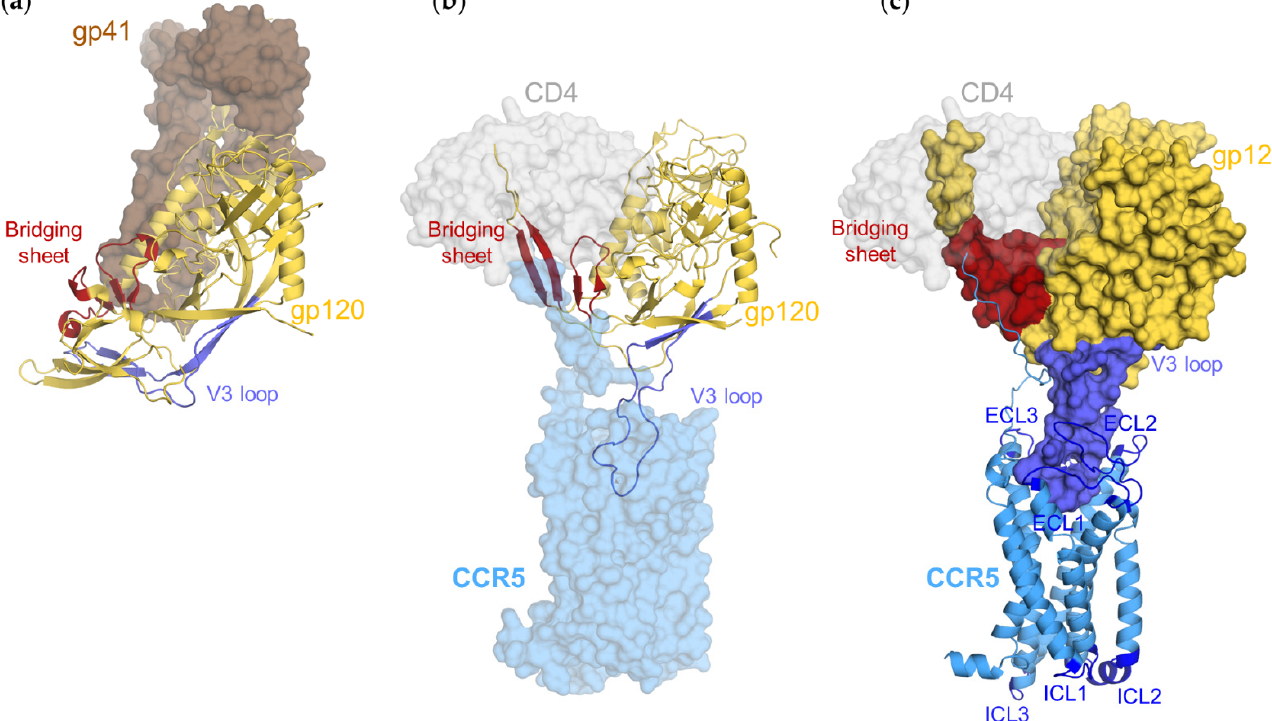
Figure 1. Structures of gp120 and its domains: ( a ) structure of closed form of gp120 (gold cartoon) in complex with gp41 (dark brown surface); ( b ) structure of open form of gp120 (gold cartoon) in complex with CD4 (gray transparent surface) and CCR5 (blue transparent surface); ( c ) structure of open form of gp120 (gold surface) in complex with CD4 (gray transparent surface) and CCR5 (blue cartoon). The gp120 V3 loop and the bridging sheet are highlighted in blue and red, respectively. The extracellular and intracellular loops of CCR5 are highlighted in dark blue. Image ( a ) prepared from PDB ID 5CEZ; Images ( b , c ) prepared from PDB ID 6MEO.